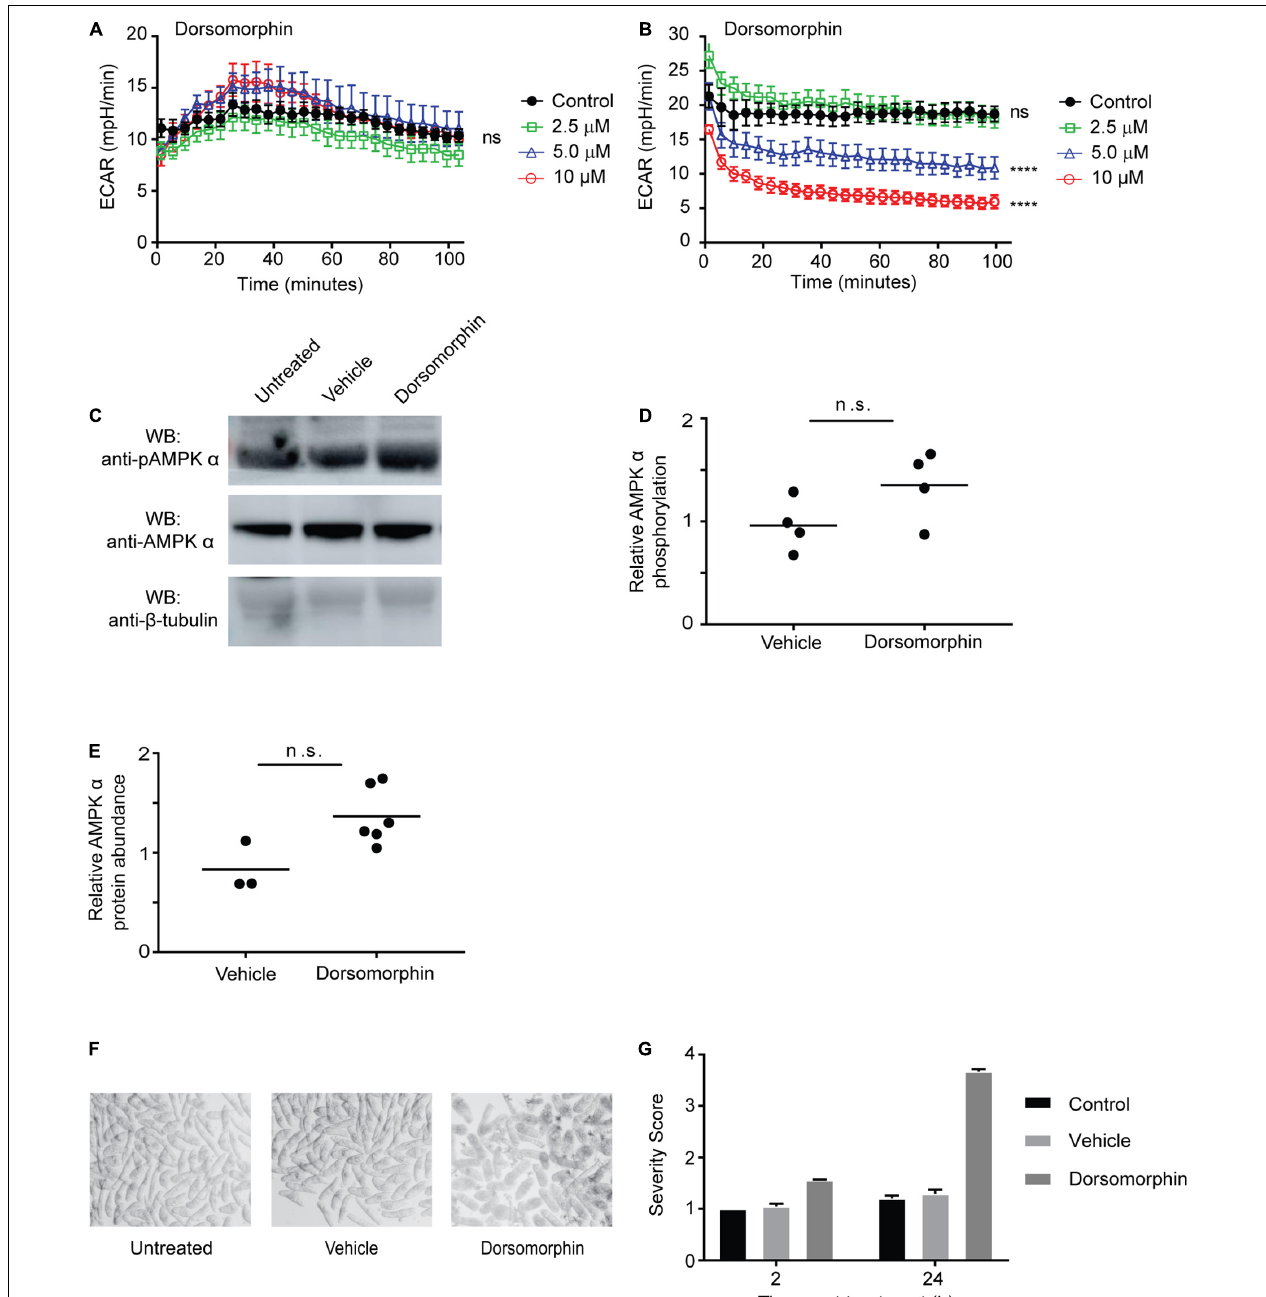
FIGURE 4 | Chemical inhibition of AMPK is toxic for juvenile schistosomes. (A,B) The extracellular acidification rate (ECAR) of schistosomula (30 min post-transformation) immediately after exposure to dorsomorphin (A) , and after 48 h of exposure to dorsomorphin (B) was measured using the Agilent Seahorse XFe96. (C) Schistosomula (30 min post-transformation) were incubated in either medium alone (untreated) or media supplemented with 10 µ M dorsomorphin or vehicle. After 24 h, lysates were prepared and equal amounts of protein were probed by Western blot using anti-pAMPK α antibody (top panel) , anti-AMPK α antibody (center panel) , and anti- β -tubulin antibody (bottom panel) . WB indicates the antibodies used for Western blotting. (D) Relative AMPK α phosphorylation under each condition was calculated by determining the ratio of anti-pAMPK α signal intensity to that of anti-AMPK α signal intensity, which was then normalized to the intensity of the anti- β -tubulin signal to control for differences in protein loading. Vehicle and dorsomorphin values shown are relative to untreated control. (E) Relative AMPK α protein abundance under each condition was calculated by determining the ratio of the intensity of the anti-AMPK α signal to that of anti- β -tubulin. Vehicle and dorsomorphin values shown are relative to untreated. Each data point shown represents a biological replicate. (F) Schistosomula (30 min post-transformation) were immediately placed in culture, in either medium alone (untreated) or medium supplemented with 10 µ M dorsomorphin or vehicle, and photographed 24 h post-incubation. (G) Schistosomula incubated in either medium alone (control), or medium supplemented with 10 µ M dorsomorphin or vehicle were phenotypically scored after 2 and 24 h incubation. Data shown are averages of at least 3 biological replicates. ns P > 0.05, **** P ≤ 0.0001.